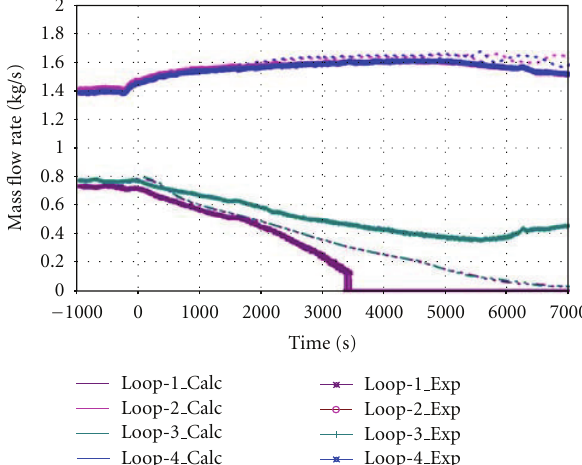
Figure 11: Run-1: Predicted mass flow rate evolution in the U-tubes of the inactive loops.